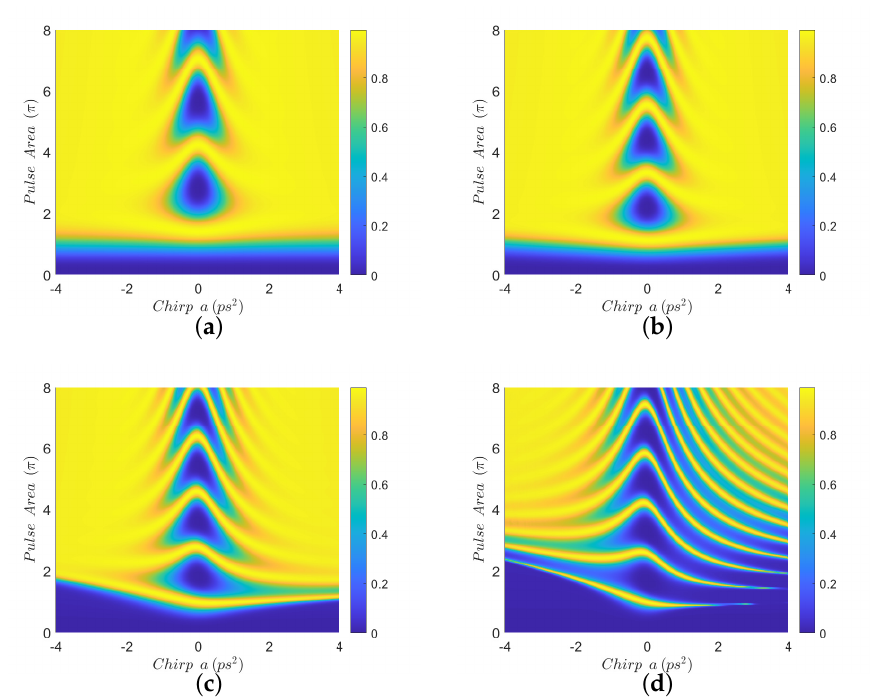
Figure 5. Contour diagrams for the biexciton population at the final time, as function of the pulse area and the chirp parameter a of the applied Gaussian pulse, with biexciton energy shift E b = 0 meV and four different interparticle distances: ( a ) R = 100 nm, ( b ) R = 15 nm, ( c ) R = 12 nm, and ( d ) R = 11